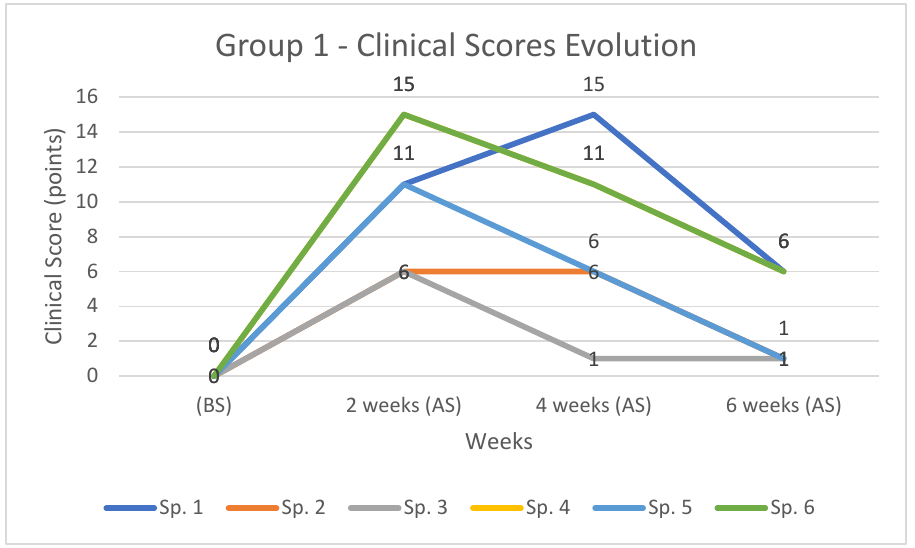
Figure 13. The evolution and comparison of clinical score for cases in group 1, (BS) and (AS) at 2, 4, and 6 weeks respectively.